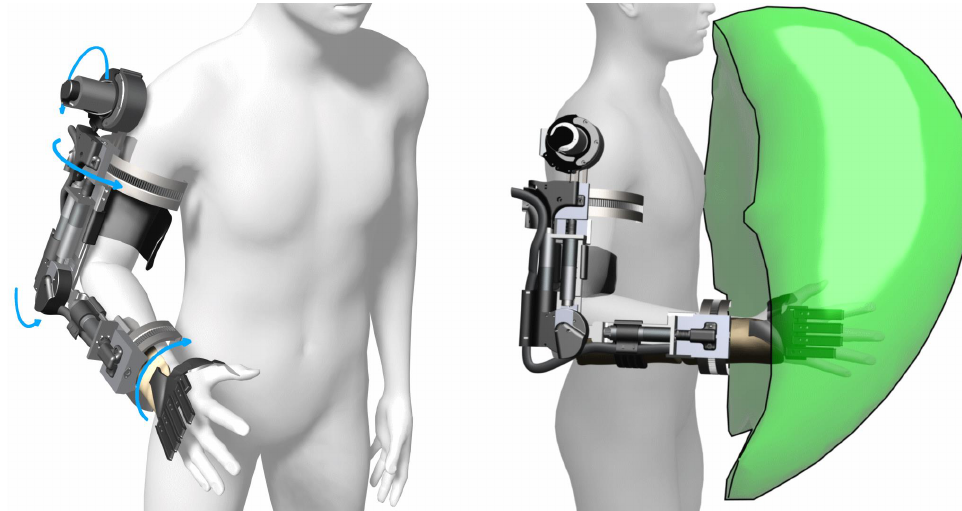
Figure 4. Three-dimensional renders of the exoskeleton with light blue arrows indicating the rota- tional joints and the available workspace indicated by the green volume on the right. Simulation was performed by permutating the joint angles over the range of motion of each joint and recording the hand location. The visualization was created from an approximation of the bounding volume of the resulting point cloud.